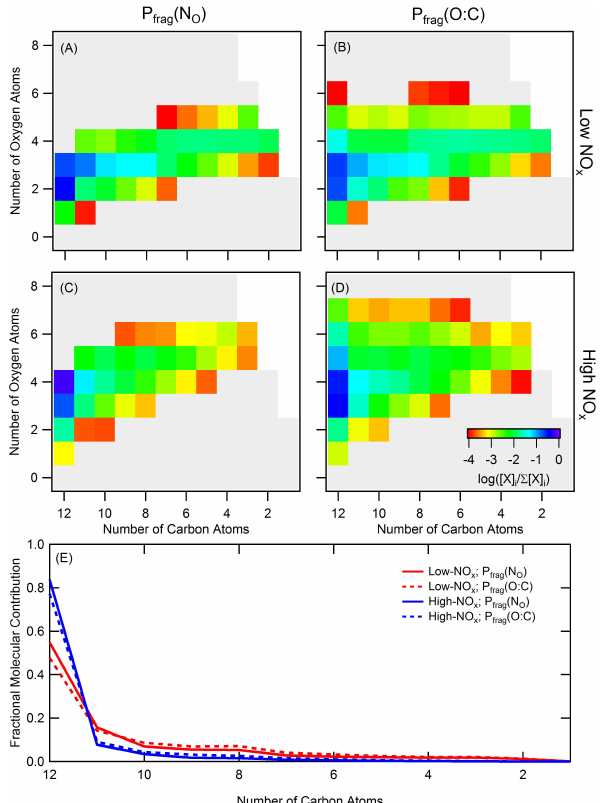
Fig. 4. Distribution of molecules comprising the model dodecane SOA at the end of the experiment for low-NO x (A, B) and high- NO x (C, D) for the P frag (N O ) (A, C) and P frag (O:C) (B, D) pa- rameterizations. The colors correspond to the log of the fractional molecular abundance, i.e. log([X] j / 6 [X] j ), with a lower-limit of − 4 (=0.01%). (E) The distributions, binned by N C , for low-NO x (red) and high-NO x (blue).